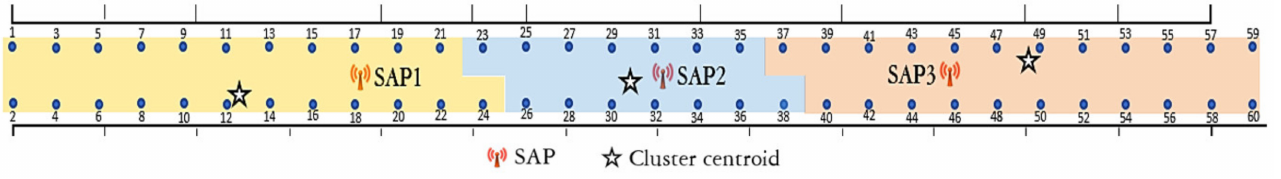
Figure 6. Floor plan with SAP clustered